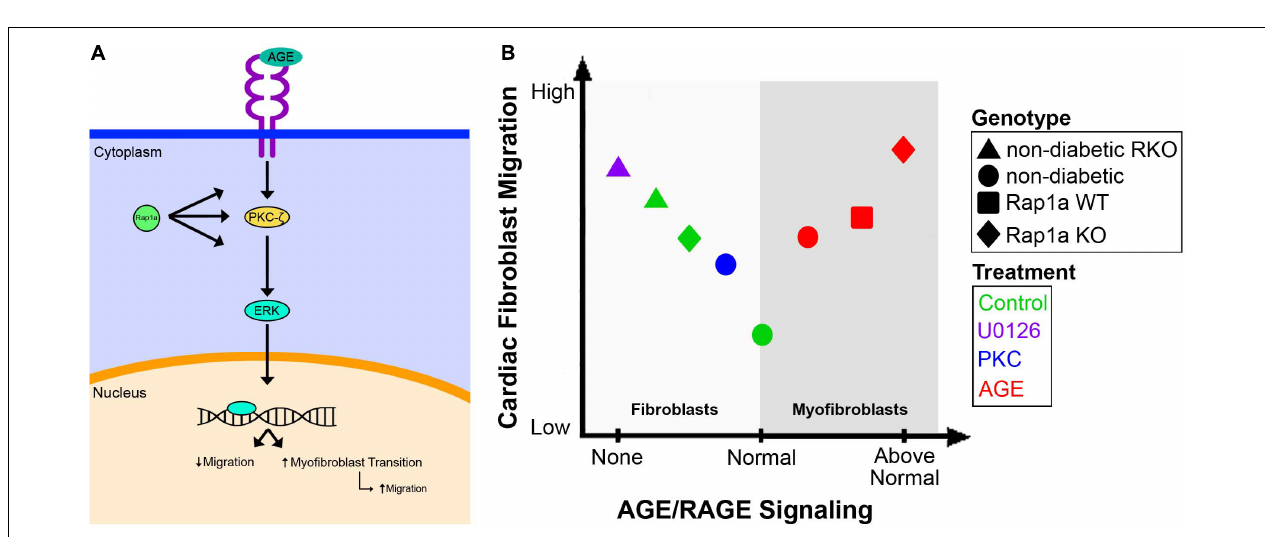
FIGURE 7 | Overview of the AGE/RAGE signaling cascade and its impact on cardiac fibroblast migration. A diagram depicted the proposed signaling network of AGE/RAGE that impacts cardiac fibroblast migration (A) . The impact of varying levels of AGE/RAGE signaling on cardiac fibroblast migration and possible differentiation (B)